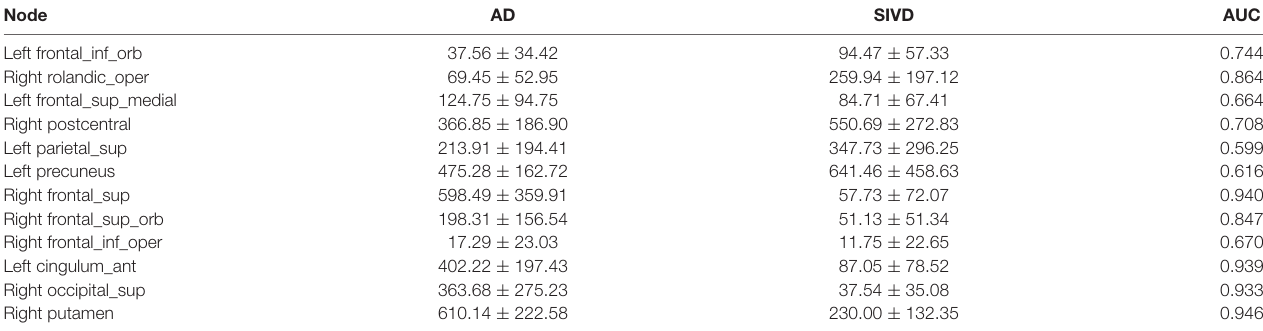
TABLE 5 | The diagnostic efficiency of nodal betweenness centrality in differentiating SIVD and AD. Node AD SIVD AUC Left frontal_inf_orb 37.56 ±